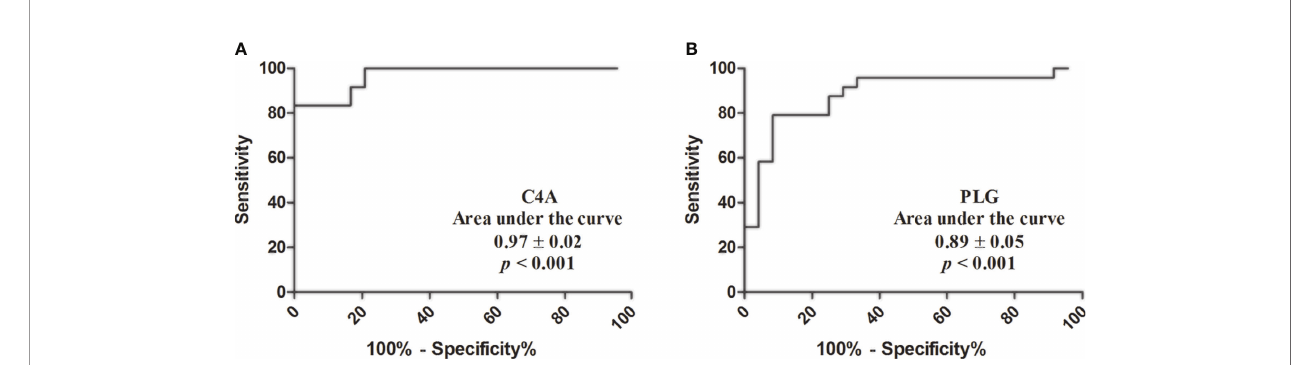
FIGURE 2 | Diagnostic value of C4A and PLG for PTC. (A) Receiver operating characteristic curves of C4A. (B) Receiver operating characteristic curves of PLG.